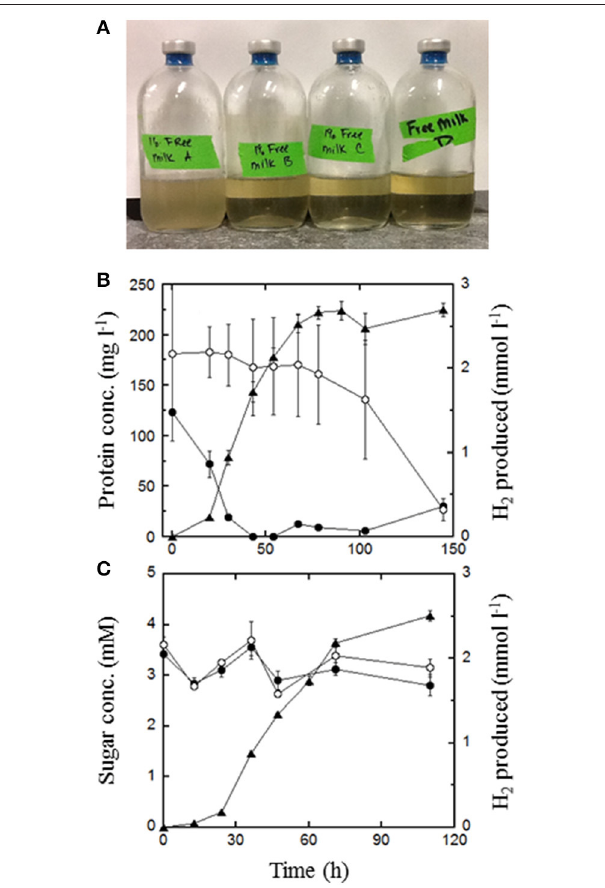
FIGURE 5 | Degradation of waste milk by T. paralvinellae during 100h of incubation at 82 ◦ C. (A) Clarification of media containing 1% waste milk from untreated cows following 100h incubation. The bottle on the left was an uninoculated control. Concentrations of protein (B) and reducing sugars (C) in 1% waste milk from untreated cows. The data shown are from inoculated bottles ( • ) and from uninoculated controls ( ◦ ) as well as H 2 produced from inoculated bottles ( N ). There was no H 2 production in uninoculated bottles. Error bars represent the standard error.